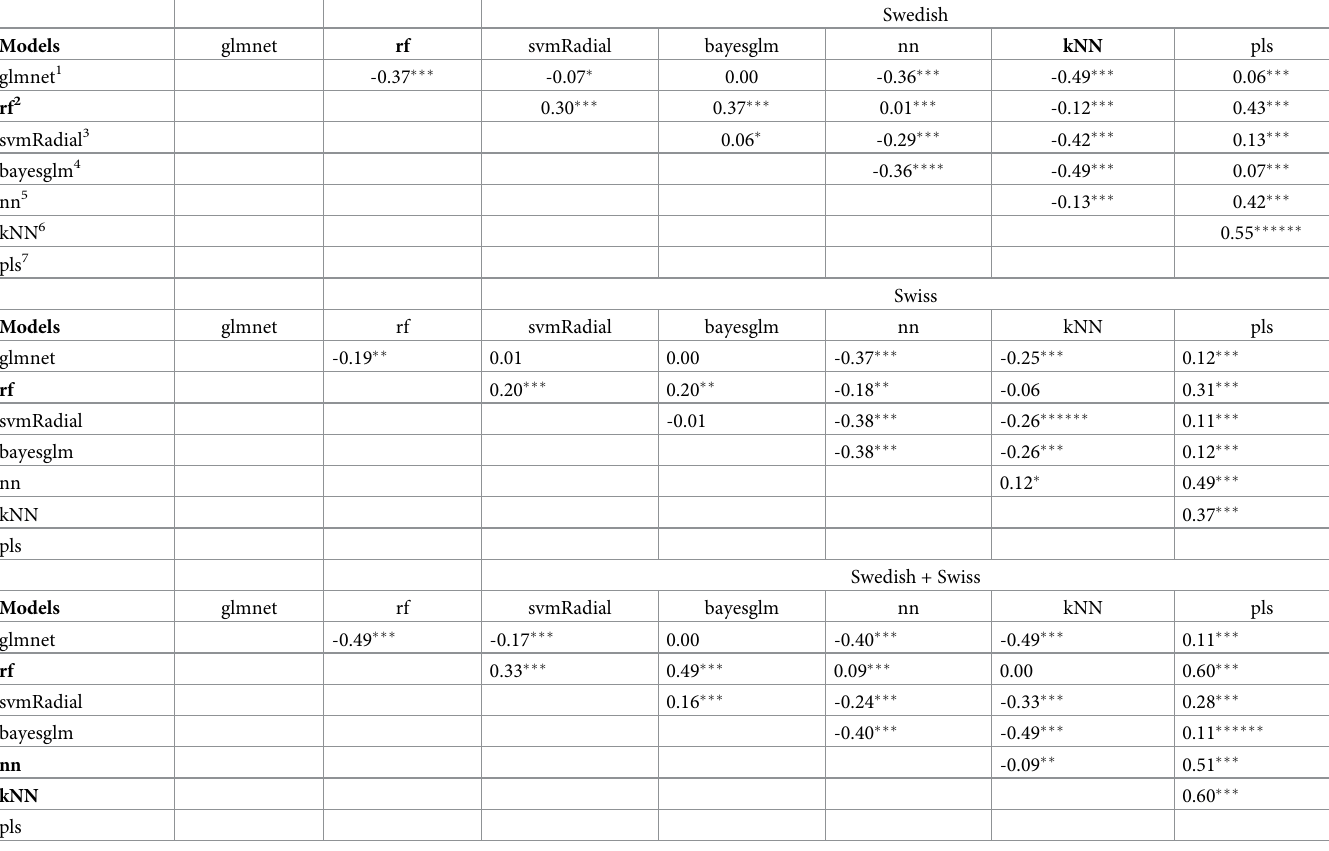
Table 8. Comparisons of models’ TPR performances when predicting unseen analysis windows [cross validation (CV) approach] of the Swedish, Swiss and Swedish +Swiss data sets. Estimated differences in TPR between the model indicated in the line header and the model indicated in the column header. Models in bold are consid- ered as the best predictive models regarding their TPR.